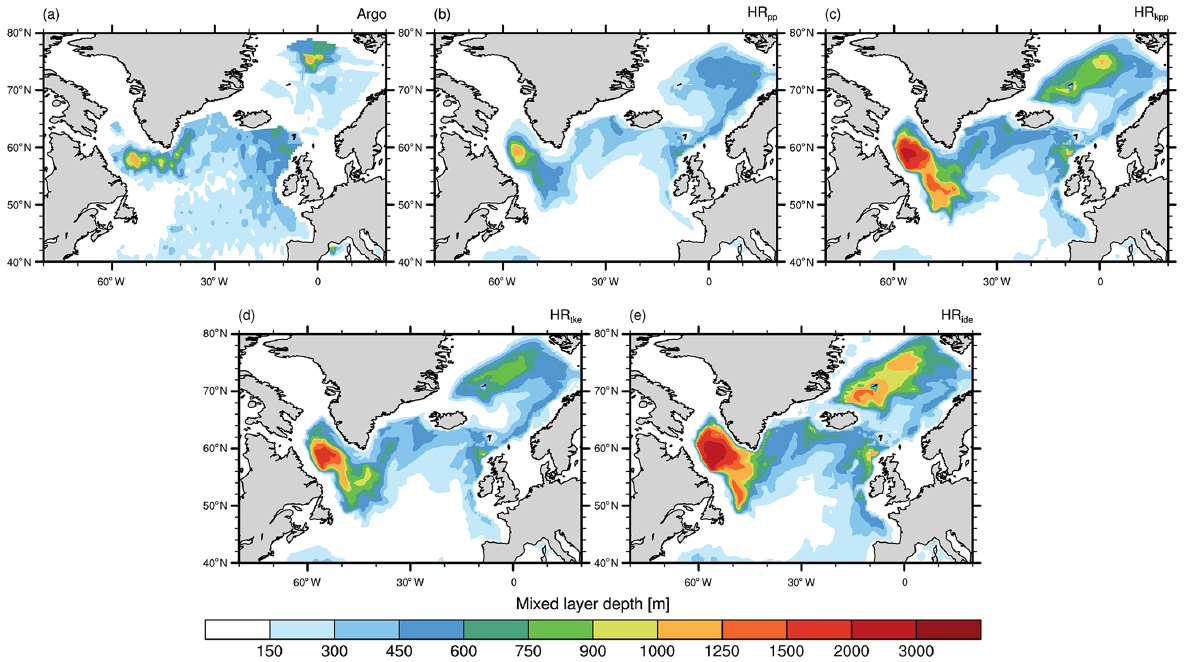
Figure 12. Time-averaged mixed layer depths (m) in March calculated by the density threshold method ( σ t = 0 . 03kgm − 3 ) from (a) 1 ◦ × 1 ◦ Argo float data (Holte et al., 2017) (mean March from 2000 to 2018) and from MPI-ESM1.2 (b) HR pp , (c) HR kpp , (d) HR tke , and (e) HR ide